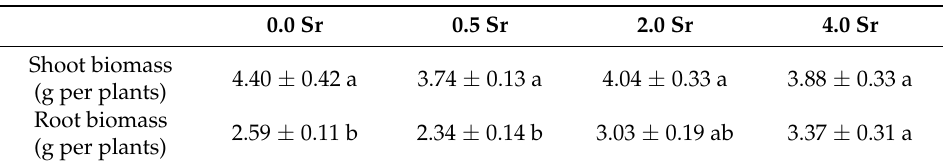
Table 1. Effect of the different strontium concentrations (mM) in the nutrient medium on the fresh biomass of soybean. Data are means ± SE ( n = 35–40); the values followed by the same letters are not significantly different ( p < 0.05, Tukey’s test).